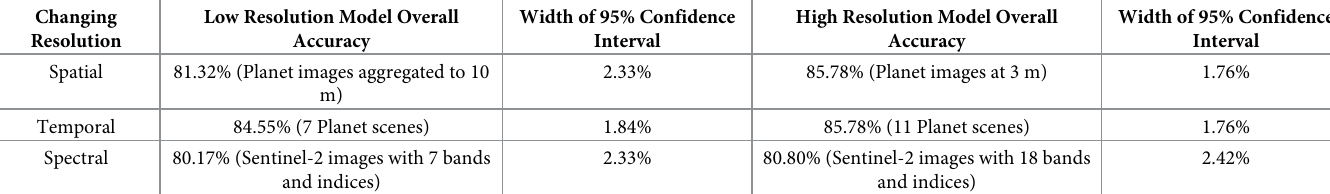
Table 7. Classification results and 95% confidence intervals for low and high spatial, temporal, and spectral resolution